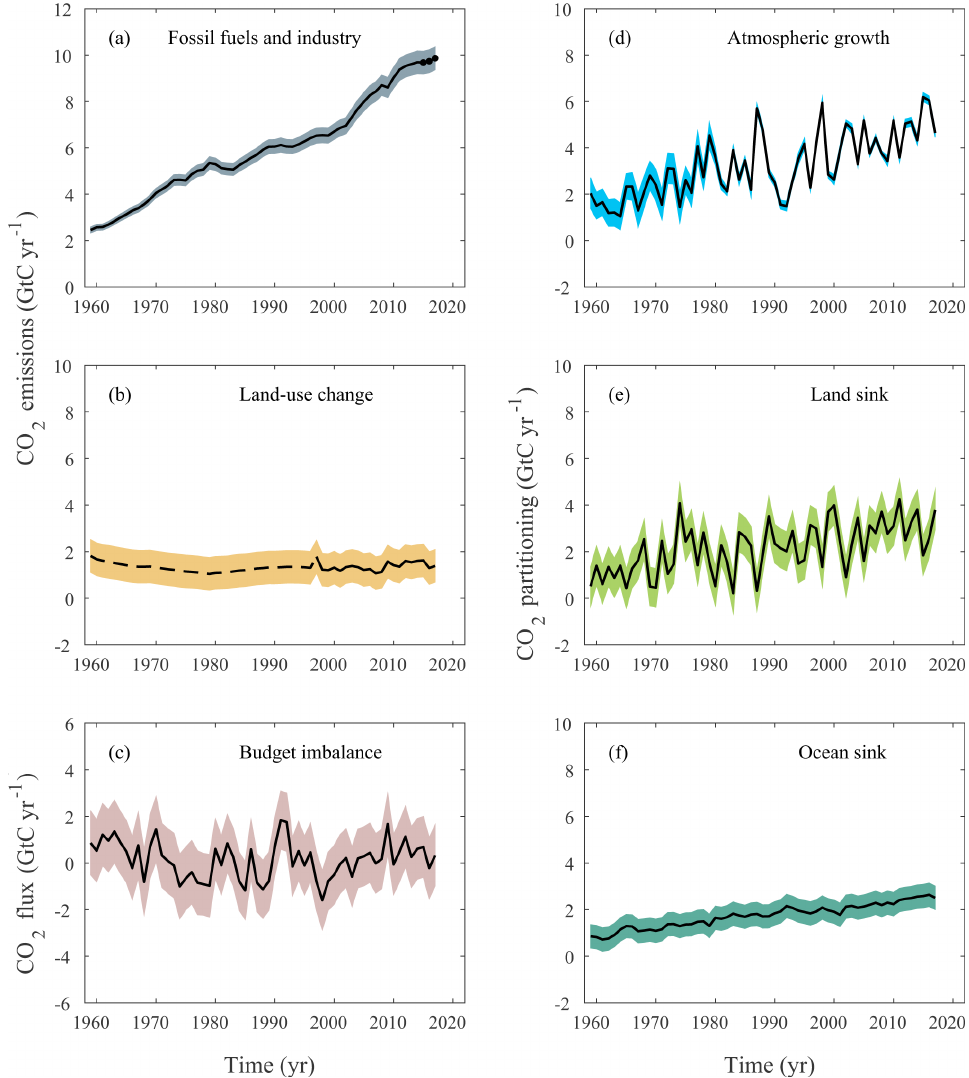
Figure 4. Components of the global carbon budget and their uncertainties as a function of time, presented individually for (a) fossil CO 2 emissions ( E FF ), (b) emissions from land-use change ( E LUC ), (c) the budget imbalance that is not accounted for by the other terms, (d) growth rate in atmospheric CO 2 concentration ( G ATM ), (e) the land CO 2 sink ( S LAND , positive indicates a flux from the atmosphere to the land), and (f) the ocean CO 2 sink ( S OCEAN , positive indicates a flux from the atmosphere to the ocean). All time series are in GtCyr − 1 with the uncertainty bounds representing ± 1 σ in shaded colours. Data sources are as in Fig. 3. The black dots in (a) show values for 2015– 2017 that originate from a different data set to the remainder of the data (see text). The dashed line in (b) identifies the pre-satellite period before the inclusion of peatland